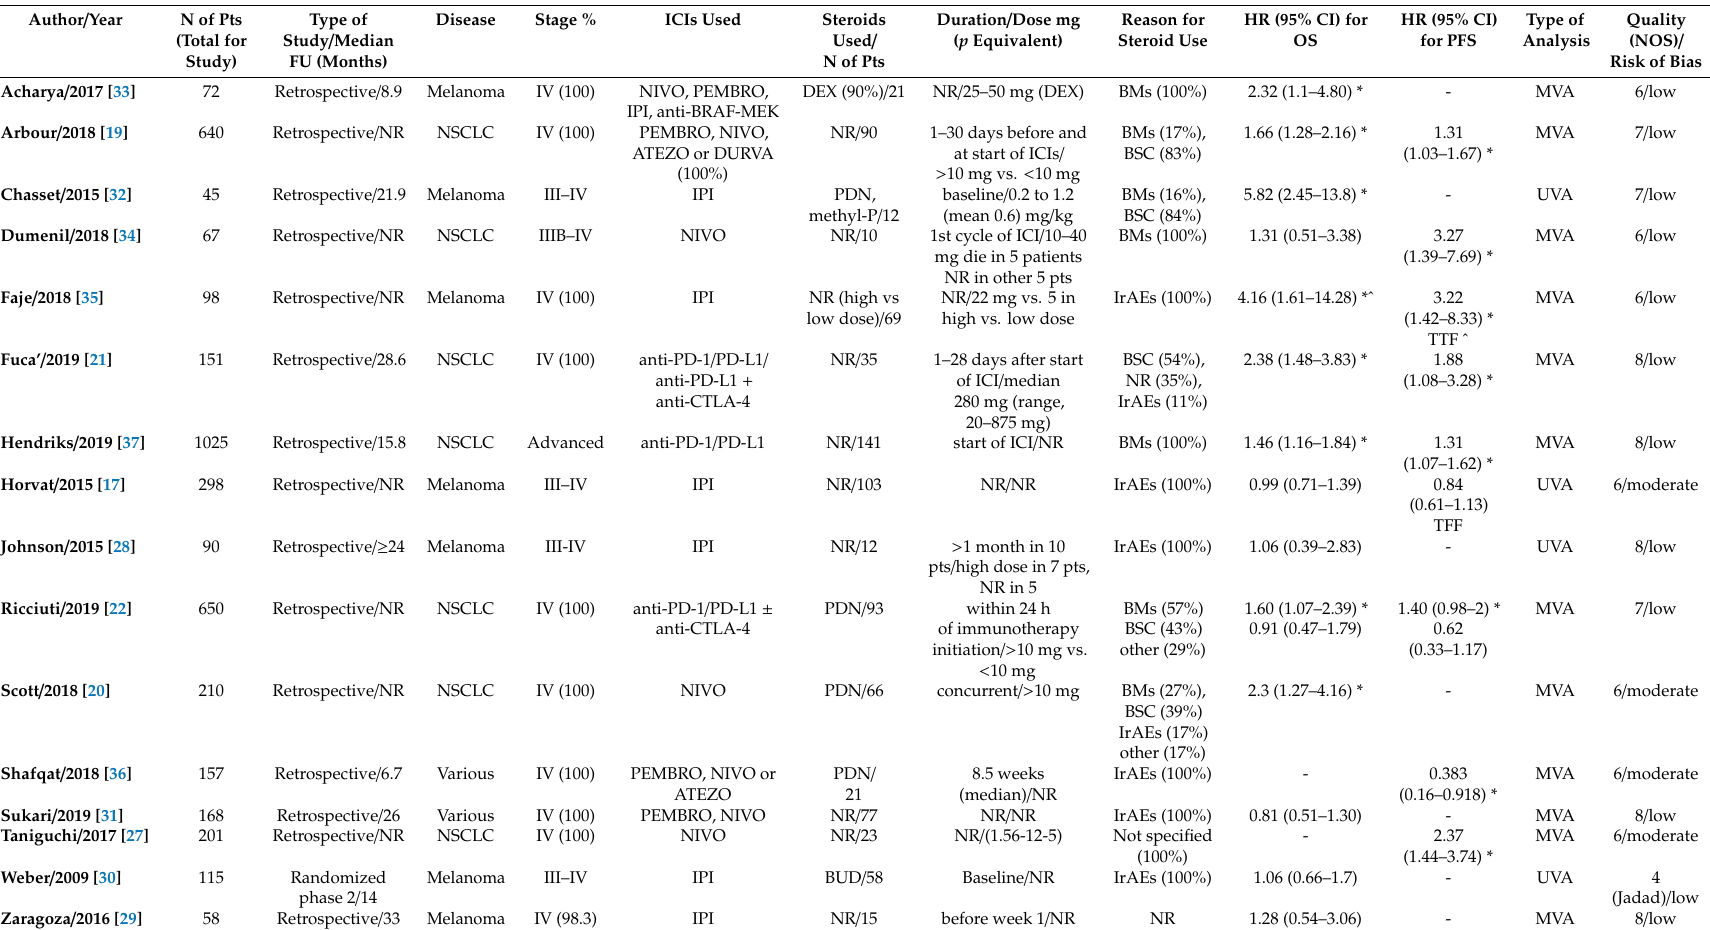
Table 1. Characteristics of included